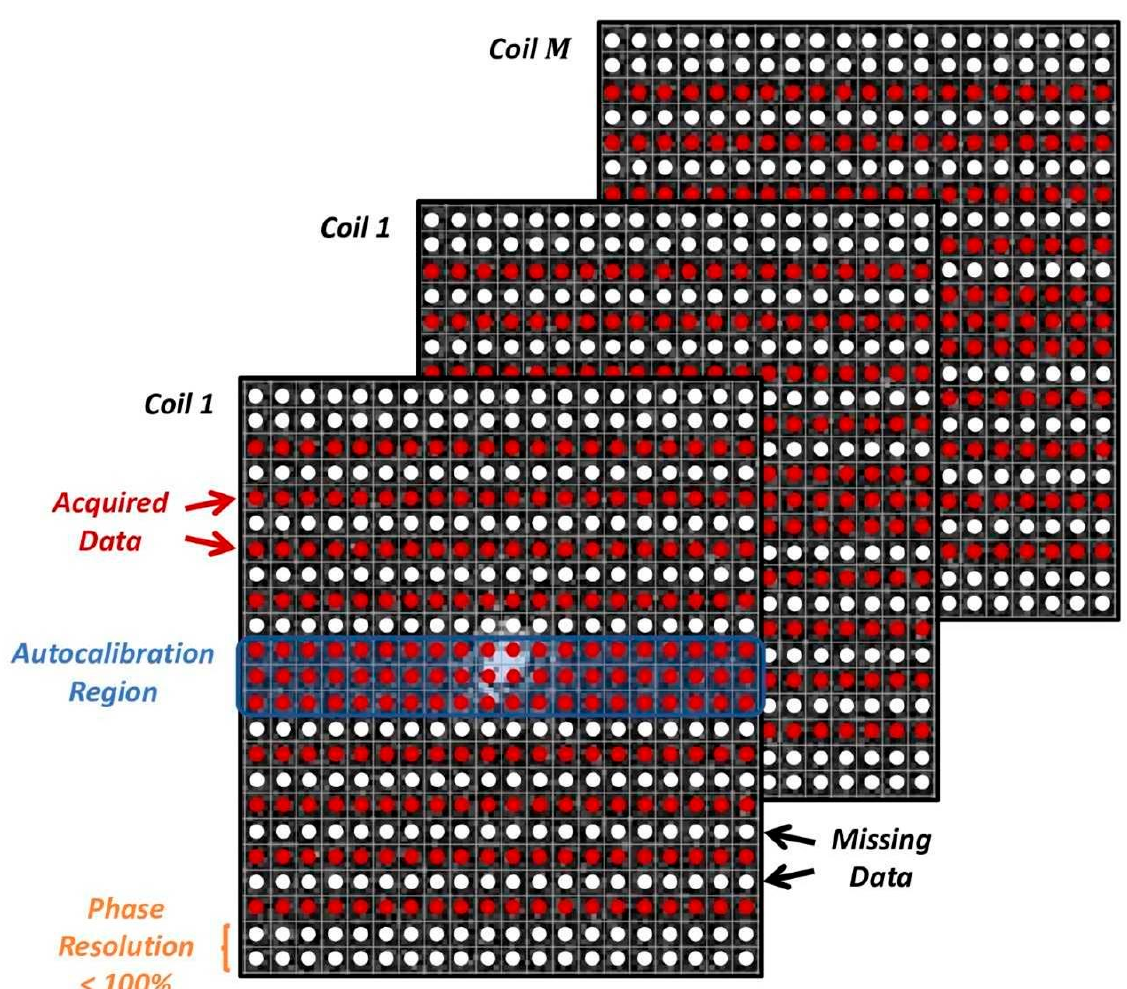
Figure 1. Exemplary sampling pattern used for the k-space data acquisition (red arrows point to the acquired date; black arrows point to the missing data). Along the phase encoding direction, data are under sampled by an acceleration factor R. An autocalibration region covering the center of k-space is acquired, either along with the imaging acquisition or separately with a different image contrast. A fraction of the periphery may be skipped, usually referred to as phase resolution.